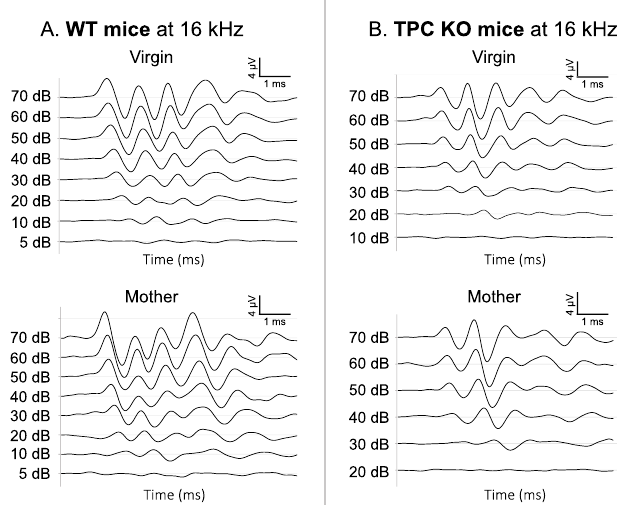
Figure 1. Individual examples of the ABR traces for the four groups. ( A ) Example of an auditory brainstem response (ABR) of a WT virgin mouse (top) and a WT mother mouse (bottom) when a 16 kHz pure tone is presented at different intensities (between 70 and − 10 dB SPL). The threshold of the virgin mouse was at 10 dB SPL and the one of the mother mouse was at 10 dB SPL. ( B ) Example of the auditory brainstem response (ABR) of a TPC KO virgin mouse (top) and a TPC KO mother mouse (bottom) when a 16 kHz pure tone is presented at different intensities (between 70 and − 10 dB SPL). The threshold of the virgin mouse was at 20 dB SPL and the one of the mother mouse was at 30 dB SPL. Mother TPC KO mice displayed higher thresholds than the mother WT mice, which was not the case in the virgin mice.